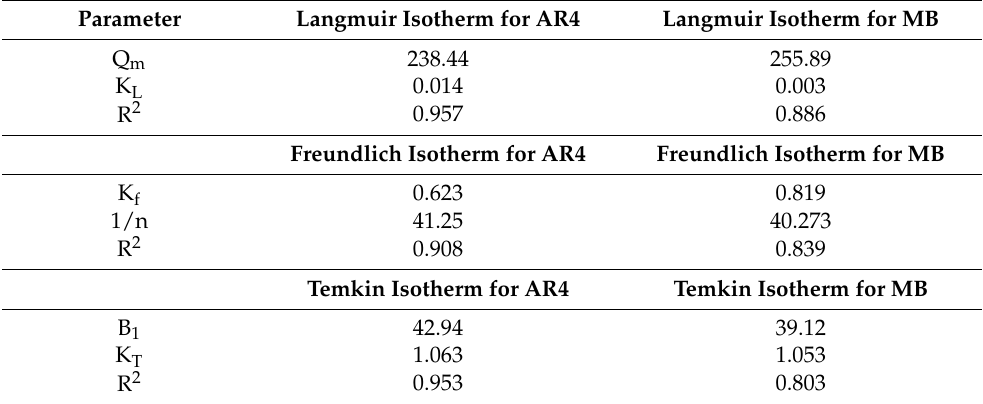
Table 5. Different isotherm parameters for the adsorption of AR4 and MB on prepared AC.